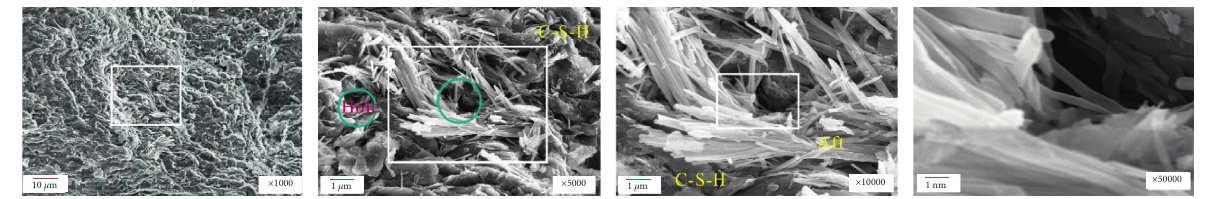
Figure 22: C-6 concrete microstructure after 400 freeze-thaw cycles.